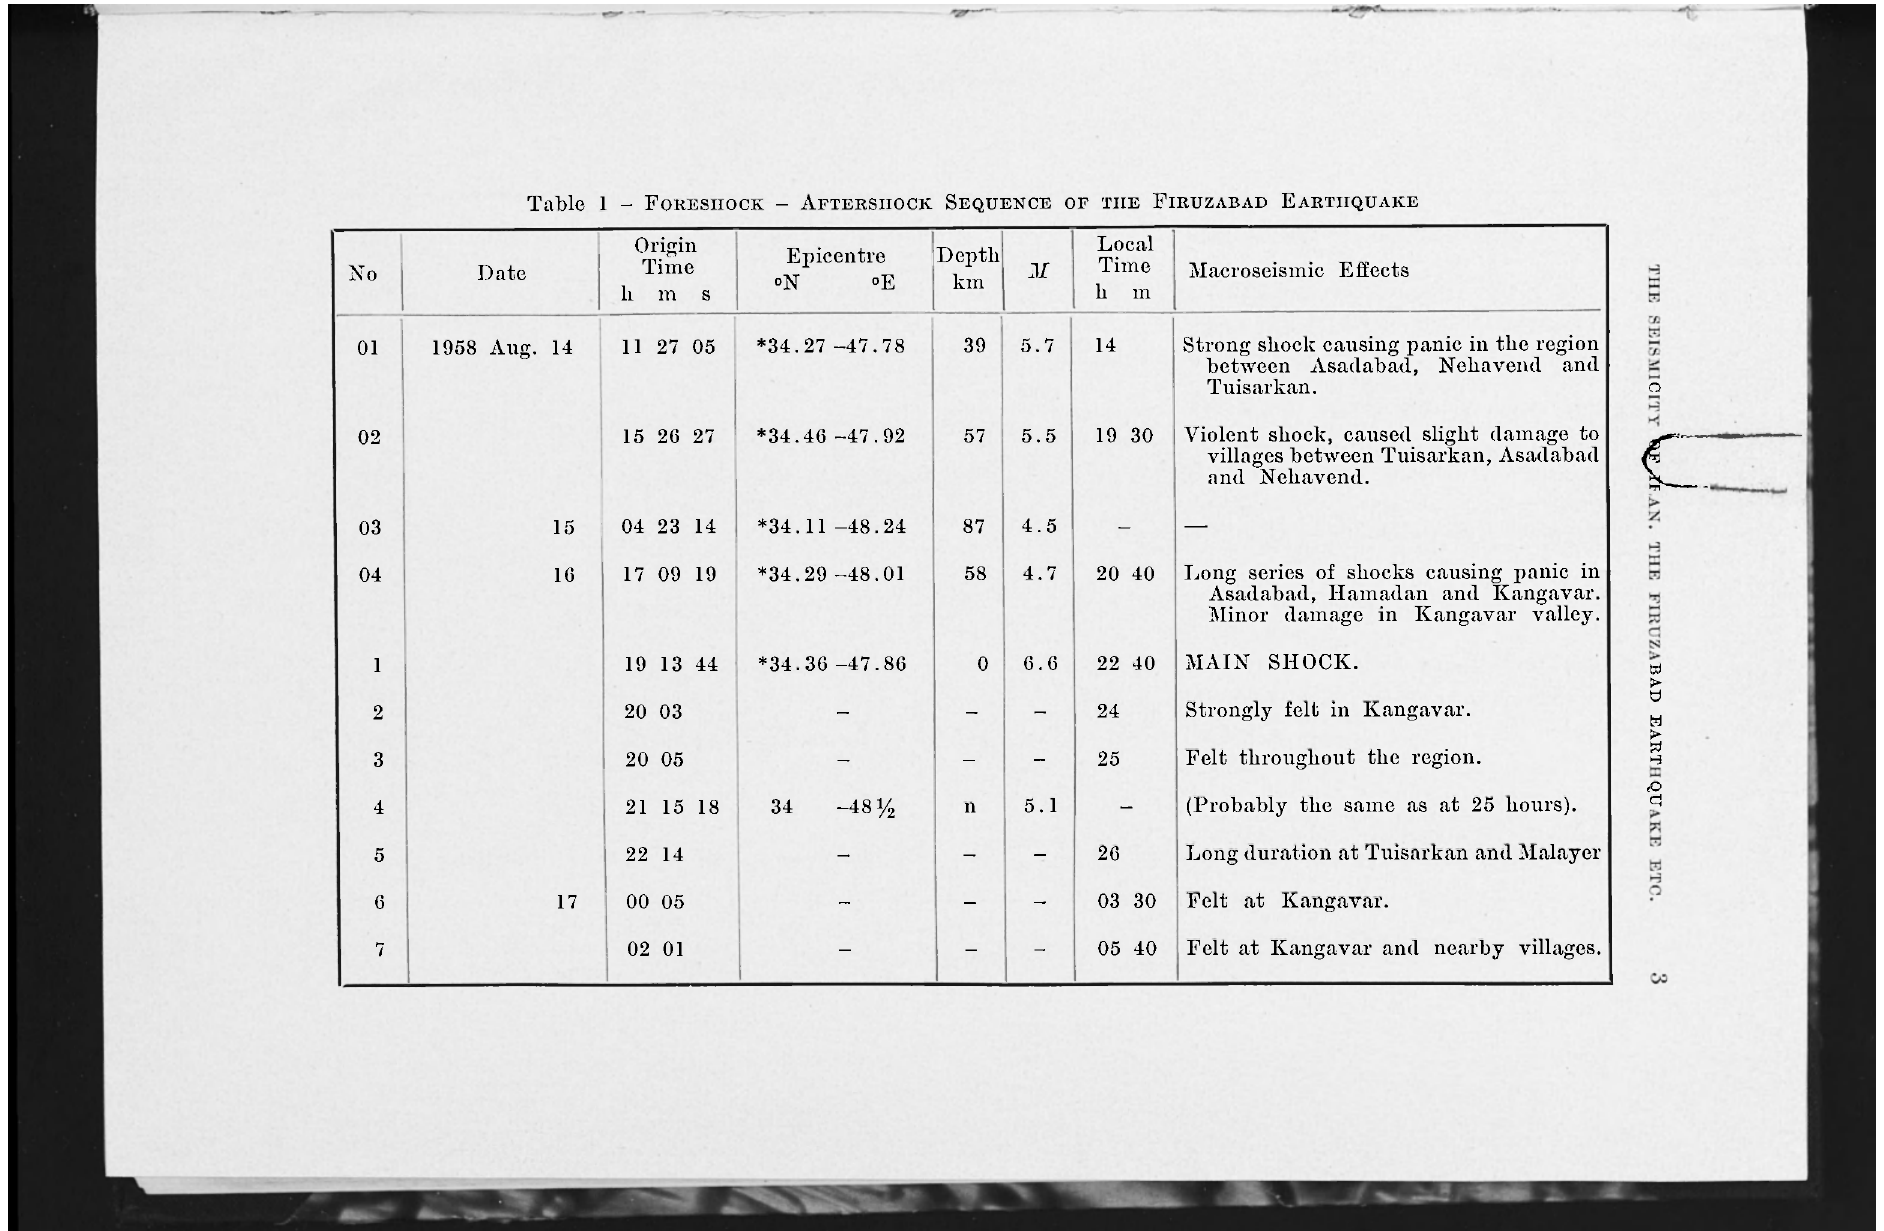
Table 1 - FORESHOCK - AFTERSHOCK SEQUENCE OF THE FIRUZABAD